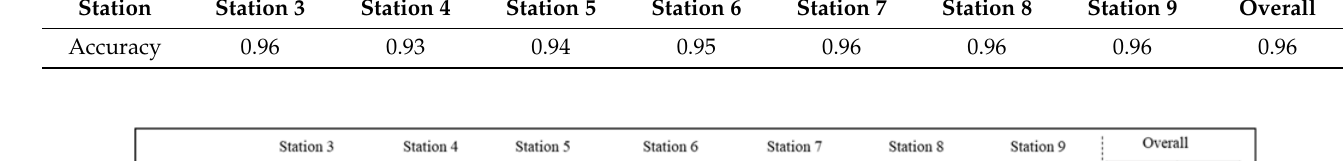
Table 2. Per-station and overall performance of workstation occupancy identi fi cation.